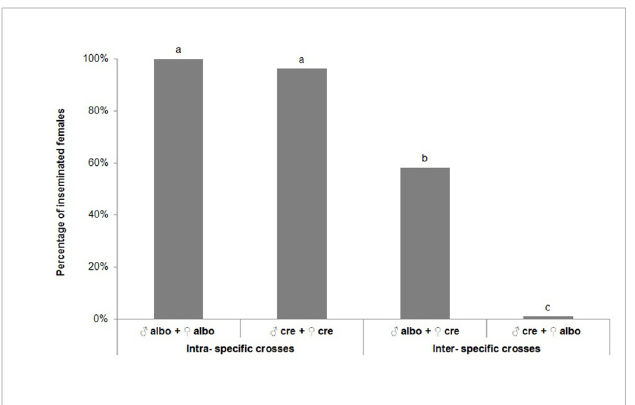
Fig 1. Percentage (%) of inseminated females after intra- and inter- specific crosses of 20 virgin Ae . albopictus and Ae . cretinus males and females. * Percentages in a column followed by different letter are significantly different ( P < 0.05), 95% Wald Confidence Interval. ** “ albo ” = Aedes albopictus , “ cre ” = Aedes cretinus